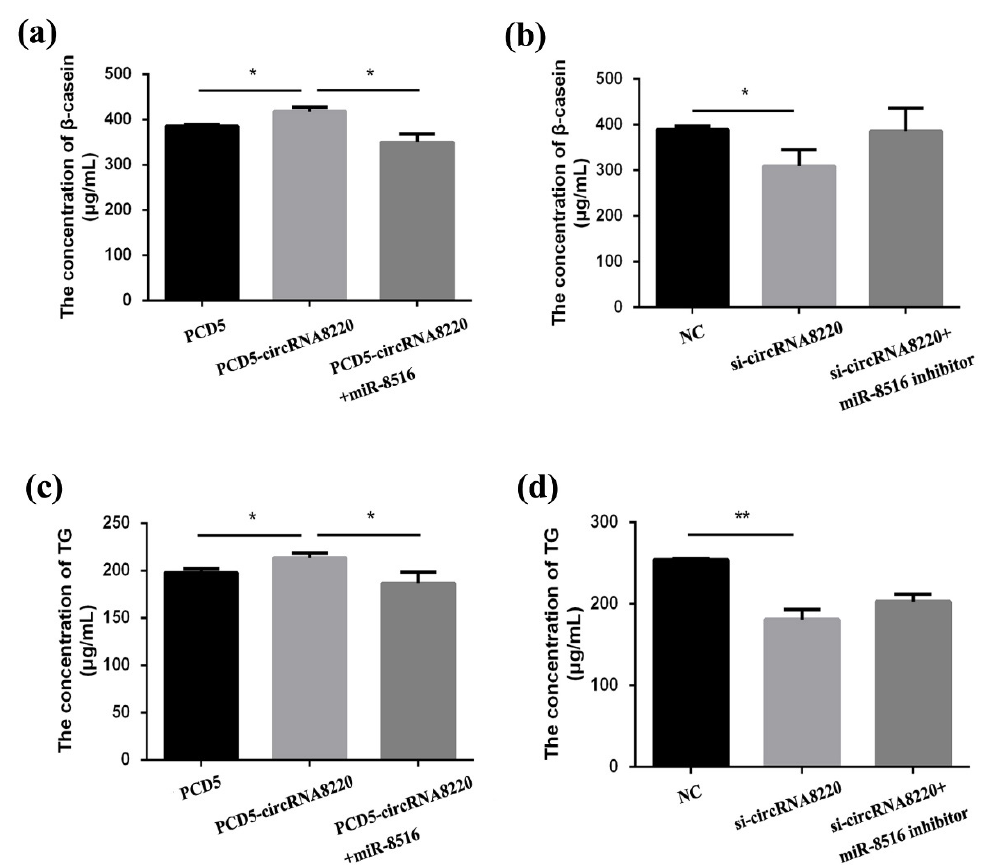
Figure 7. circRNA8220 enhanced the synthesis of β -casein and triglycerides in GMEC. ( a – d ) Secretion of β -casein and triglycerides (TG) after transfected with PCD5-circRNA8220 or si-circRNA8220 was measured by enzyme-linked immunosorbent assay kit. ** p < 0.01, * p <